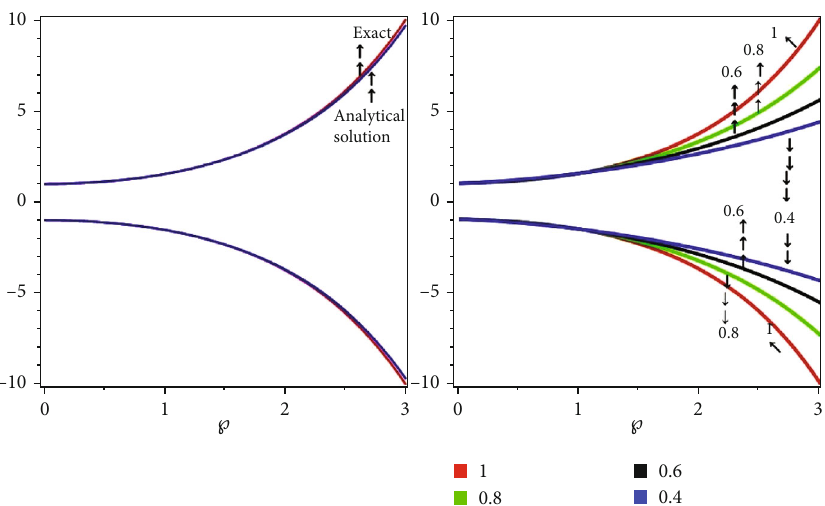
Figure 1: The fi rst graph depicts a two-dimensional fuzzy upper and bottom branch graph of an analytic series result, while the second depicts various fractional of ρ